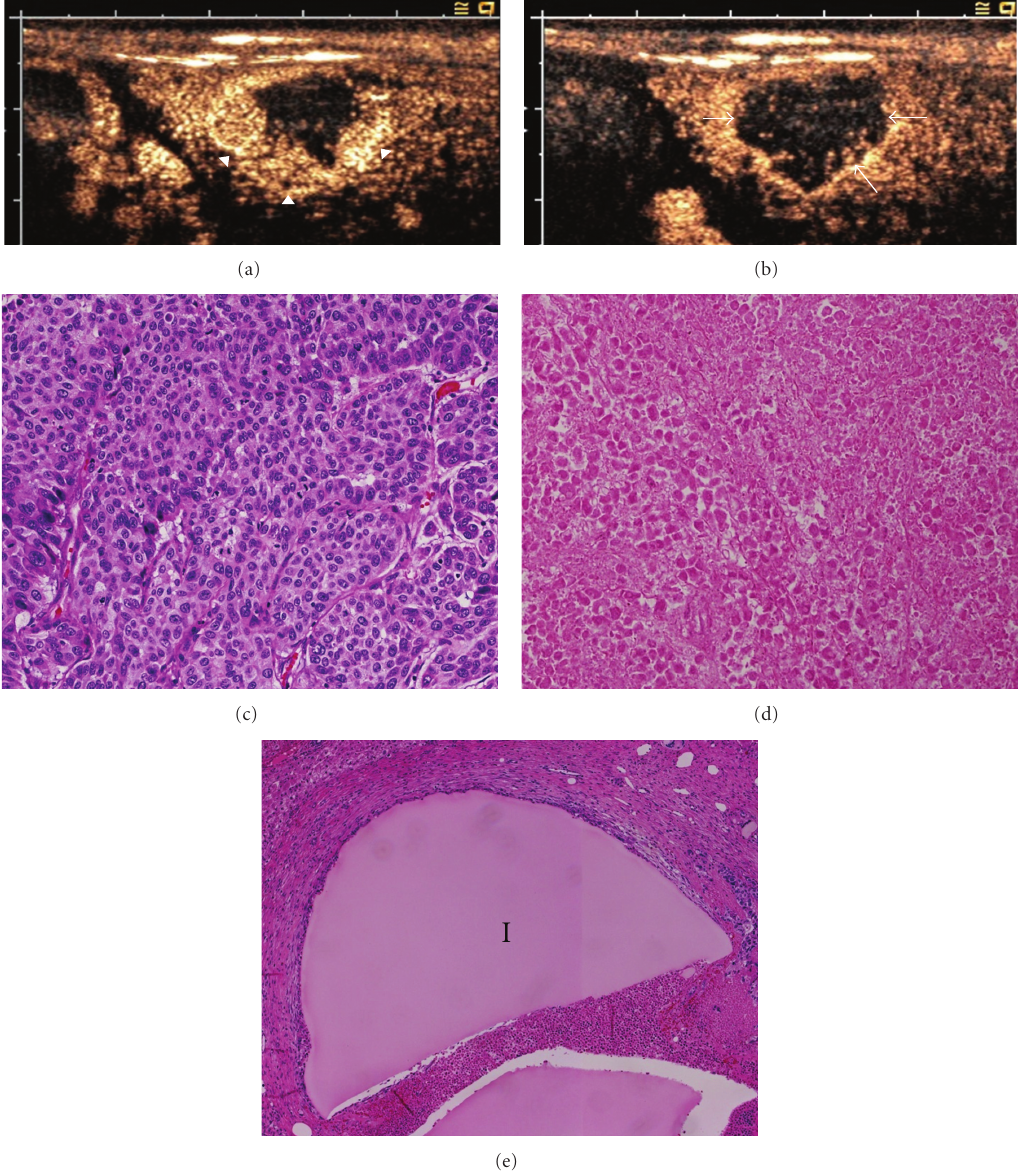
Figure 2: Sonazoid-enhanced ultrasonographic and histopathological examination. (a) Immediately after Sonazoid administration, the tumor shows a strong contrast e ff ect, depending on the vascular distribution, particularly in the marginal area (arrowheads). (b) While the tumor lacks a contrast e ff ect 10min after administration of Sonazoid (the Kup ff er phase), the edge can be clearly visualized (arrows). (c) Cellular colonies with adequately stained nuclei and cytoplasm can be observed in the viable (c) but not the necrotic portion (d). A deposit of iodized oil ( I ) remains in the destroyed vascular structure (e). (c–e): hematoxylin-eosin staining, 20x original